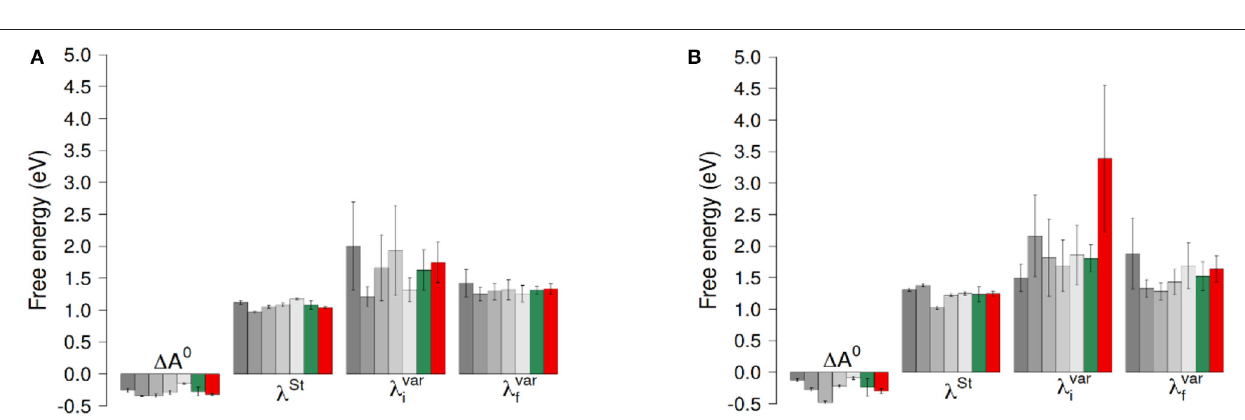
E X stands for the energy of the heme in the redox state X ( O ∨ R gX